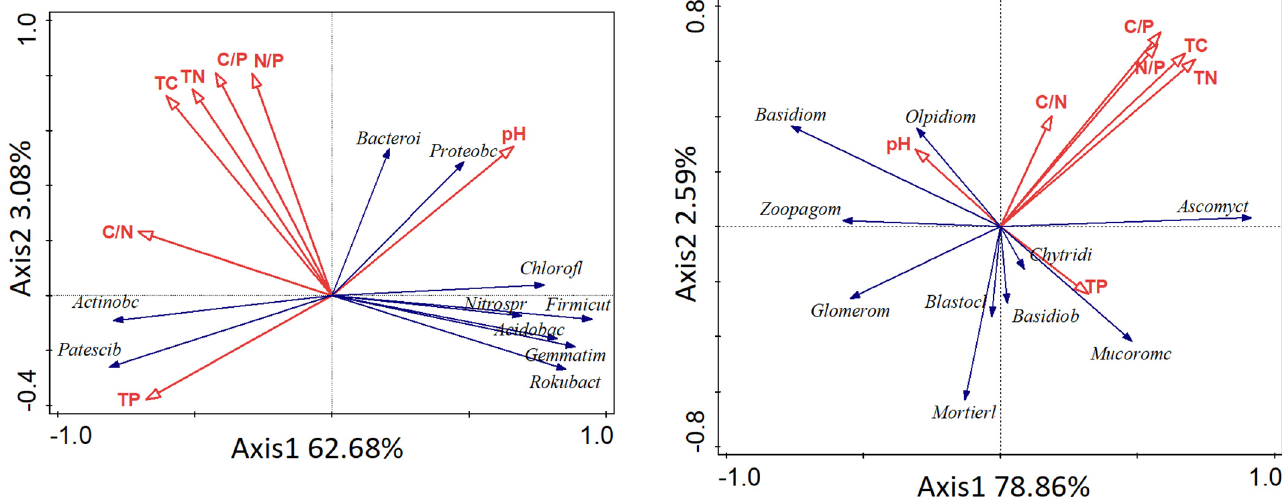
Figure 6. Correlation between soil physical and chemical properties and soil microorganisms.